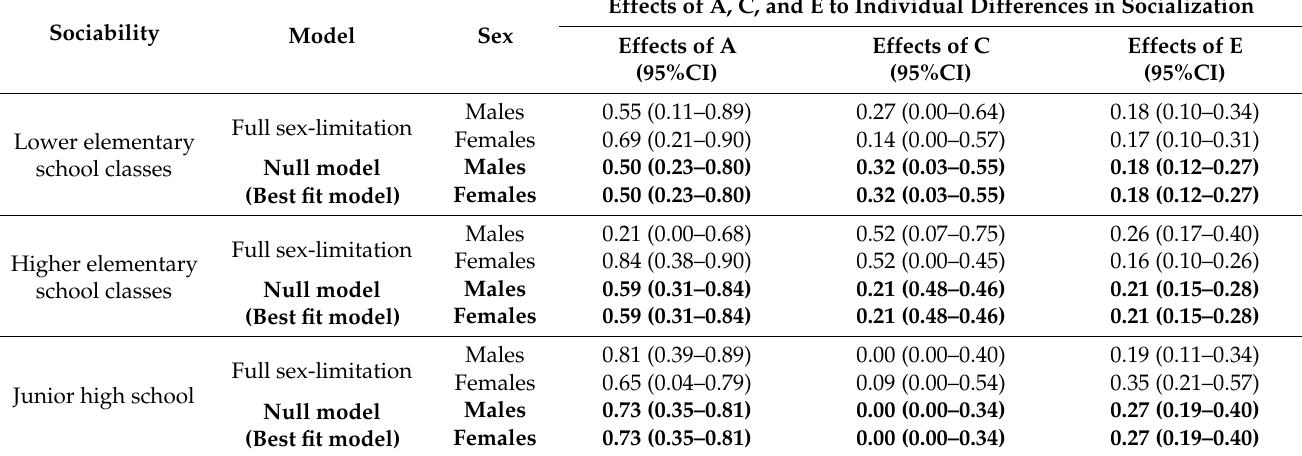
Table 7. Parameter estimates of sociability from sex-limitation model